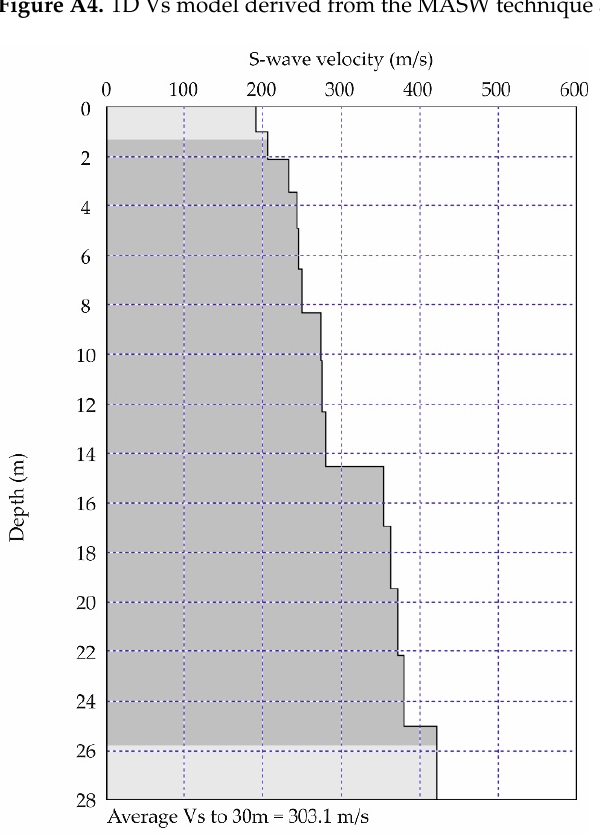
Figure A5. 1D Vs model derived from the MASW technique at THAL station.